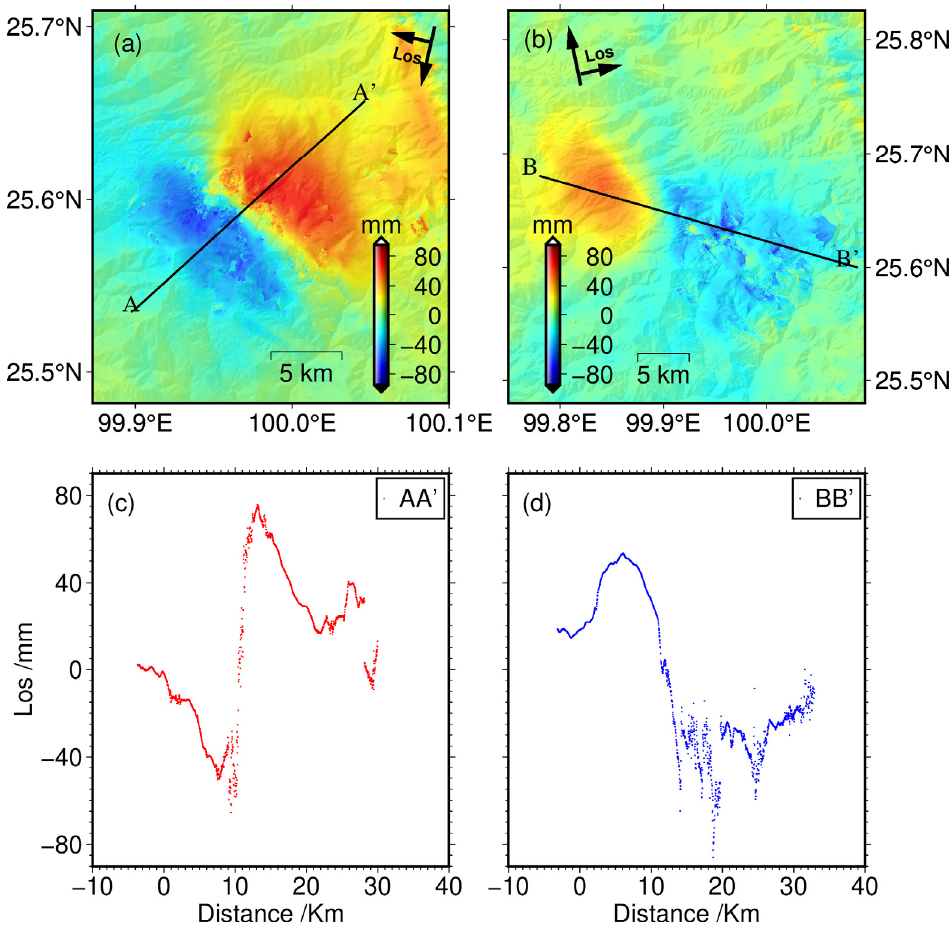
Figure 2. The coseismic deformation fields derived from the Sentinel-1 descending ( a ) and ascending ( b ) images. Cross-sections along A–A’ (black line) and B–B’ (black line) for the ( c ) descending and ( d ) ascending images. Table 1. Sentinel-1A image used in this